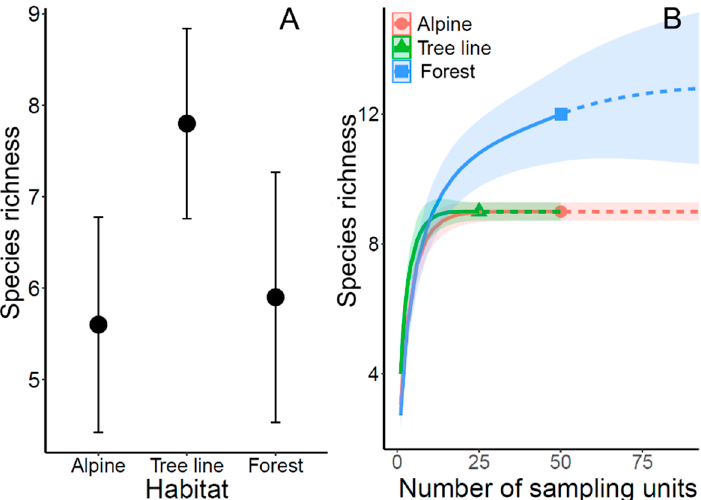
Figure 3. ( A ) Mean ant species richness among the three habitat types. Whiskers show the 95% confidence intervals. ( B ) Species accumulation curves as a function of sampling units, based on ant species incidences. Symbols: observed species richness. Dashed lines: extrapolated species richness. Shaded areas: 95% confidence limits of the curves. In subalpine forest, ant species richness was distinctly higher than on the tree line and in alpine grassland, and some further species might have been detected with more intense sampling in forest.